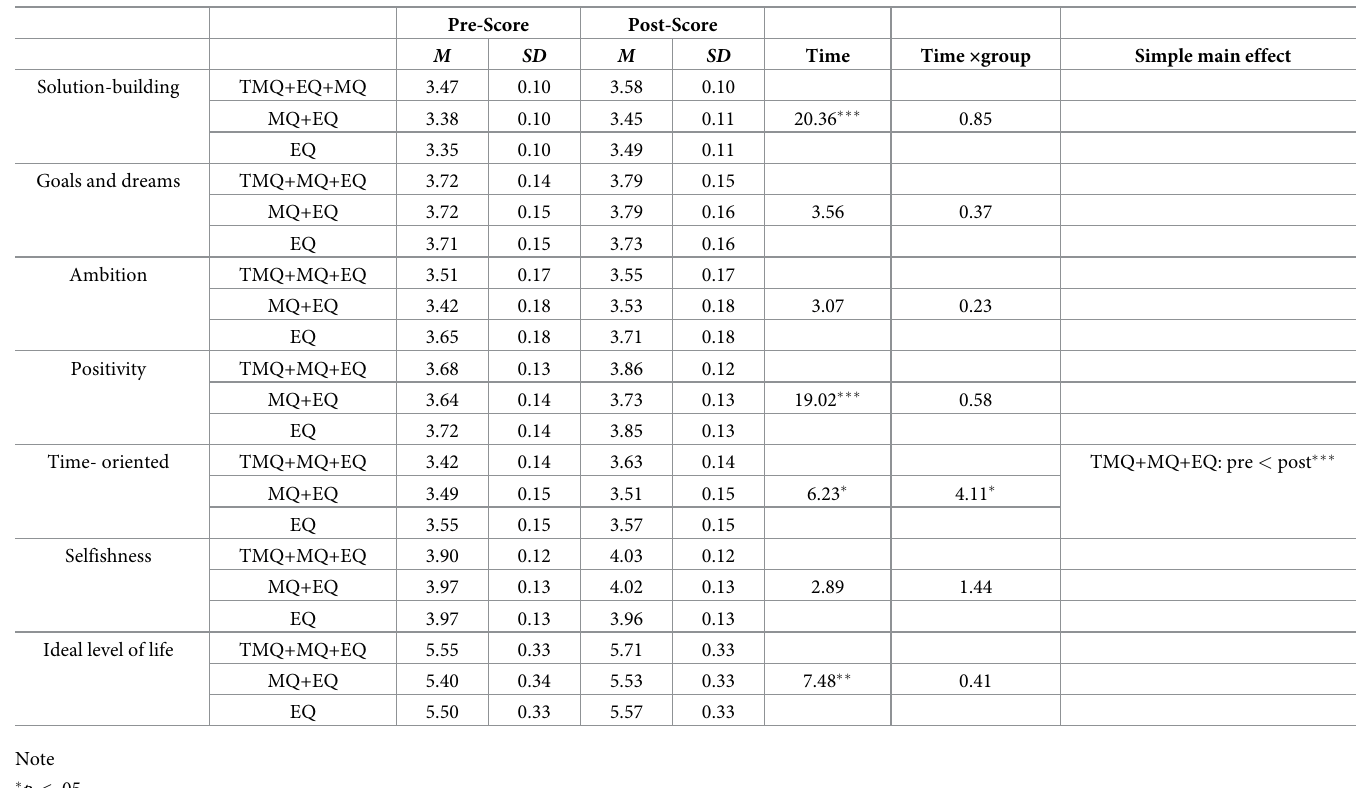
Table 2. Comparison between the groups of the pre- post-scores by repeated measures ANOVA.